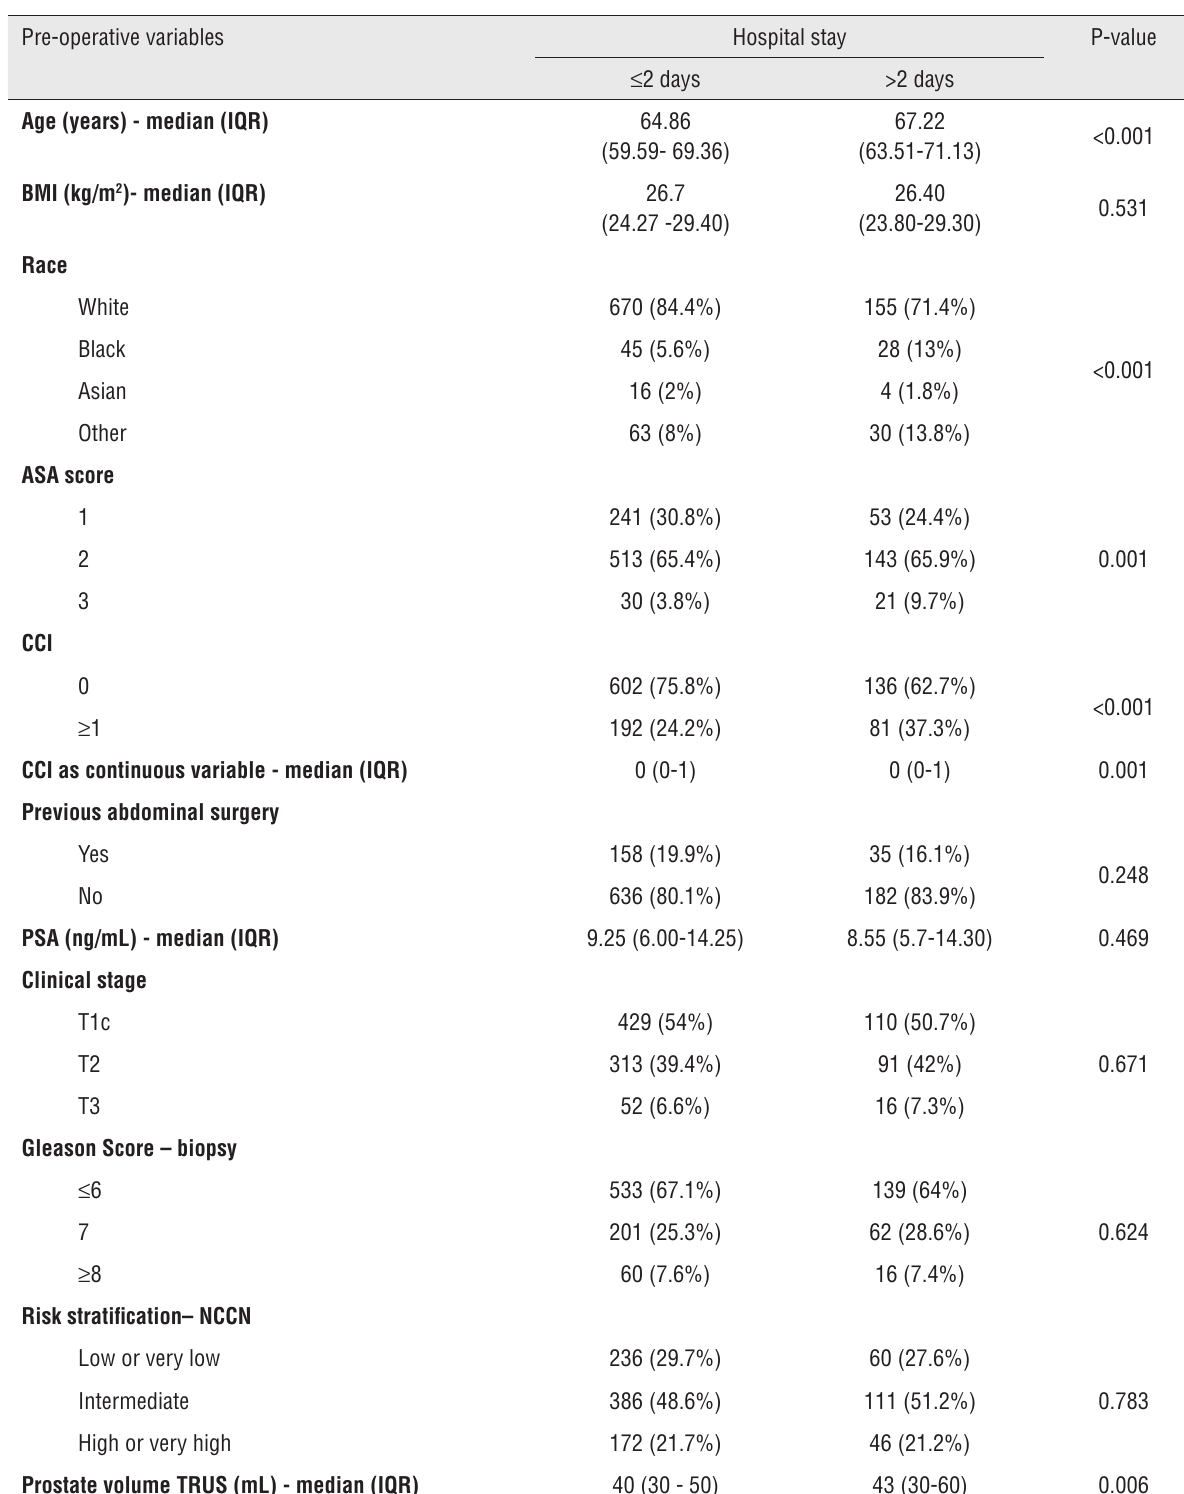
Table 6 - A) Univariate analysis – Predictors of prolonged hospitalization amongst pre-operative variables. Pre-operative